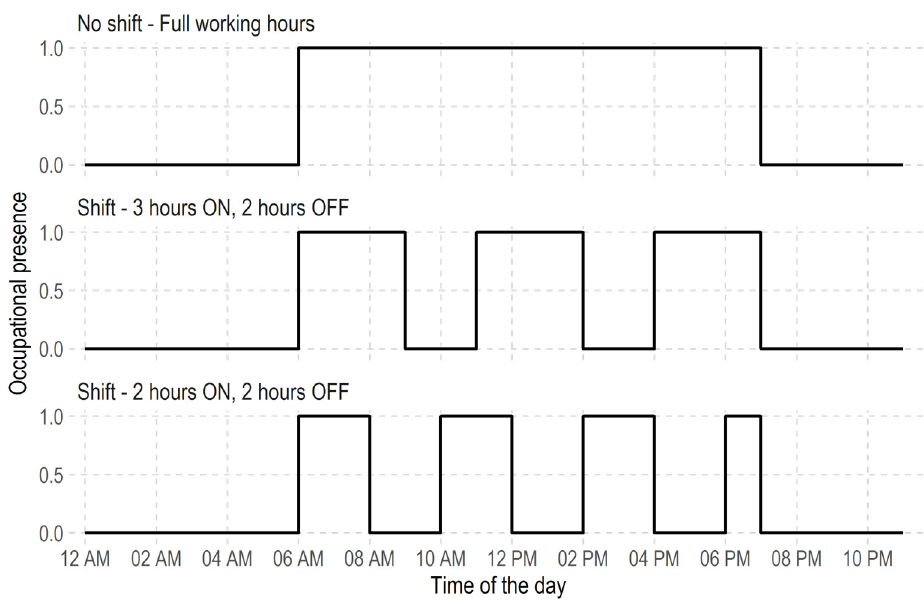
Figure 4. Hourly shift scenarios for exposure control intervention. Table 2. Combination of scenario variables for assessing the effect of intervention on exposure. Case-ID Mask